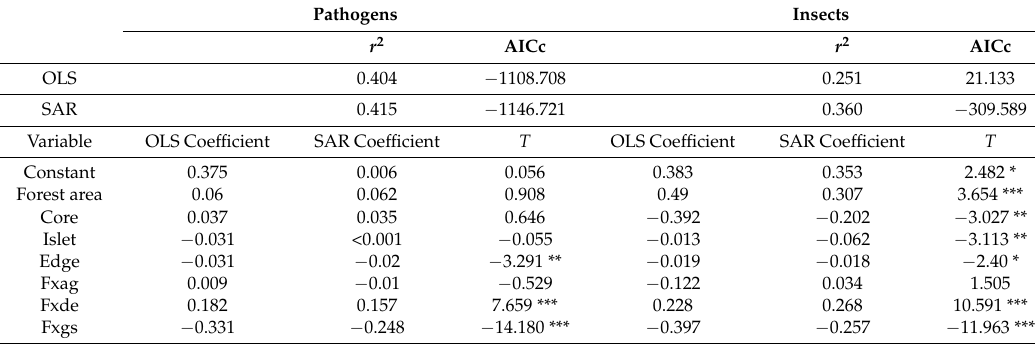
Table 3. Effects of forest fragmentation and edge types on pest richness (pathogens vs. insects) across the forests in the conterminous United States based on the ordinary-least-squares (OLS) estimation and spatial autoregression analyses (SAR). Data were aggregated to the county level ( N = 2098) and were log(x + 1)-transformed before